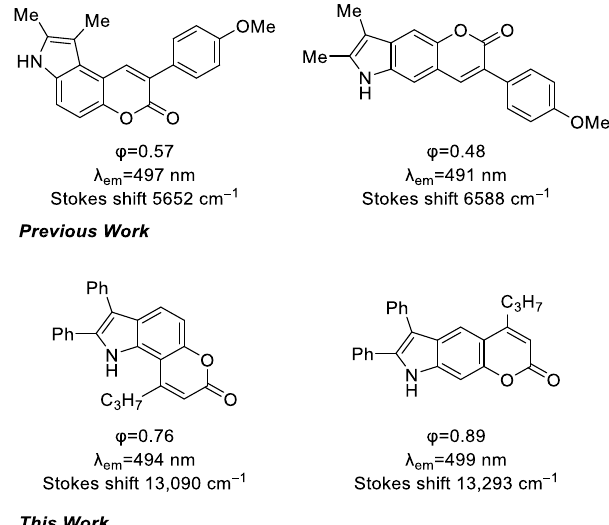
Figure 11. Photophysical characteristics of pyranoindoles obtained in the previous and current